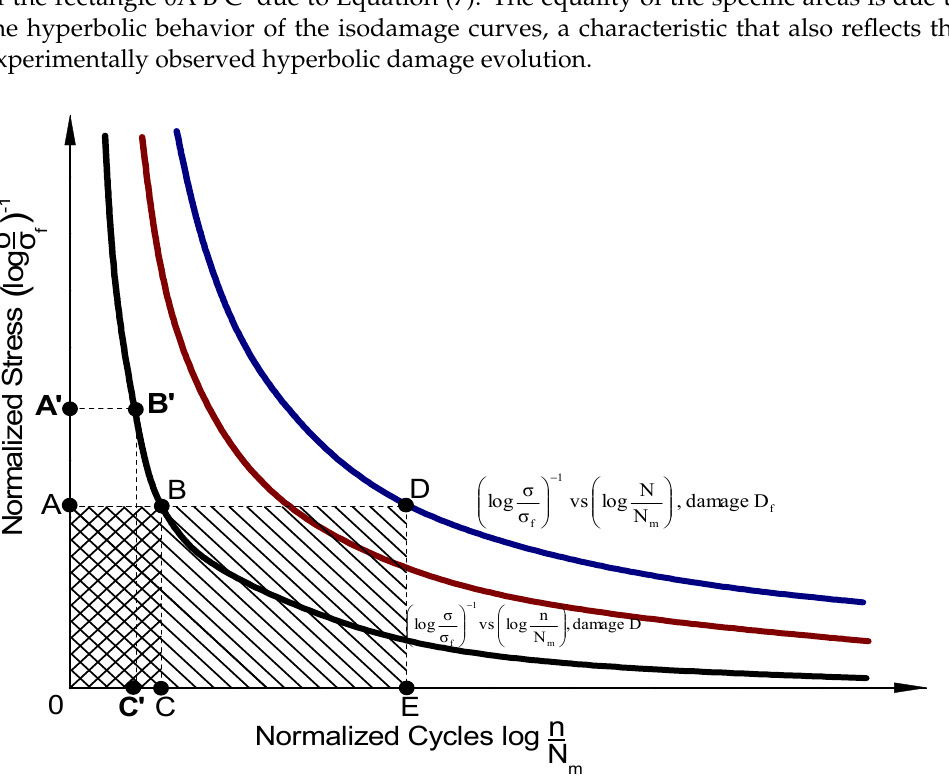
Figure 1. Fatigue damage concept of composite laminates schematically.